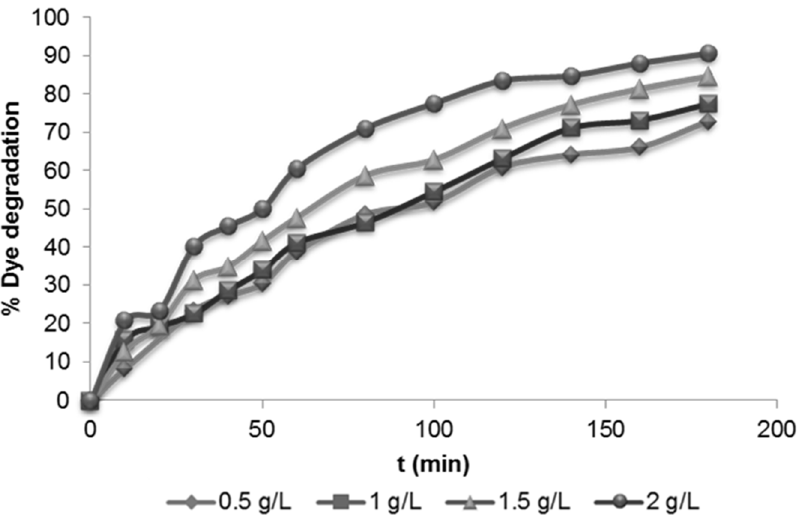
Figure 5. Evolution of the dye degradation for different TiO 2 loading (initial dye concentration = 75 mg·L − 1 ).